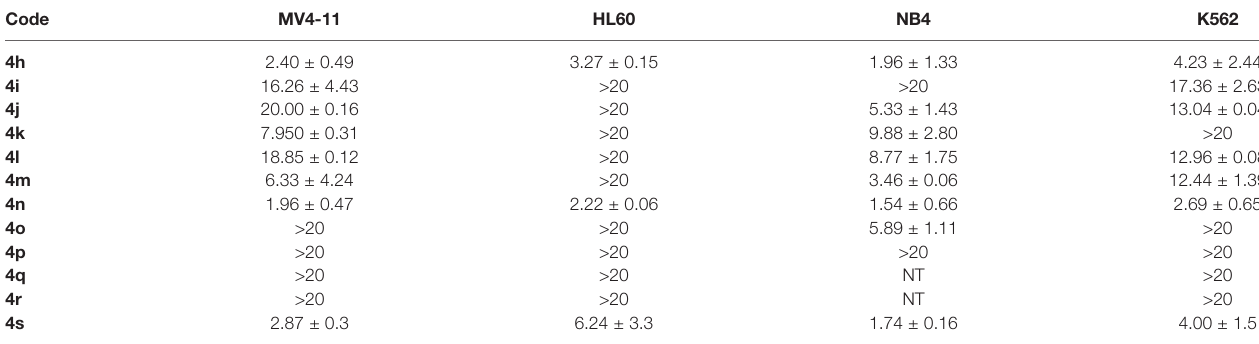
TABLE 2 | Results of cytotoxic activities of compounds against leukemia cell lines expressed as IC 50 ± SEM (µM). MV4-11, HL60 and NB4 are AML cell lines. K562 cell line is CML cell line.